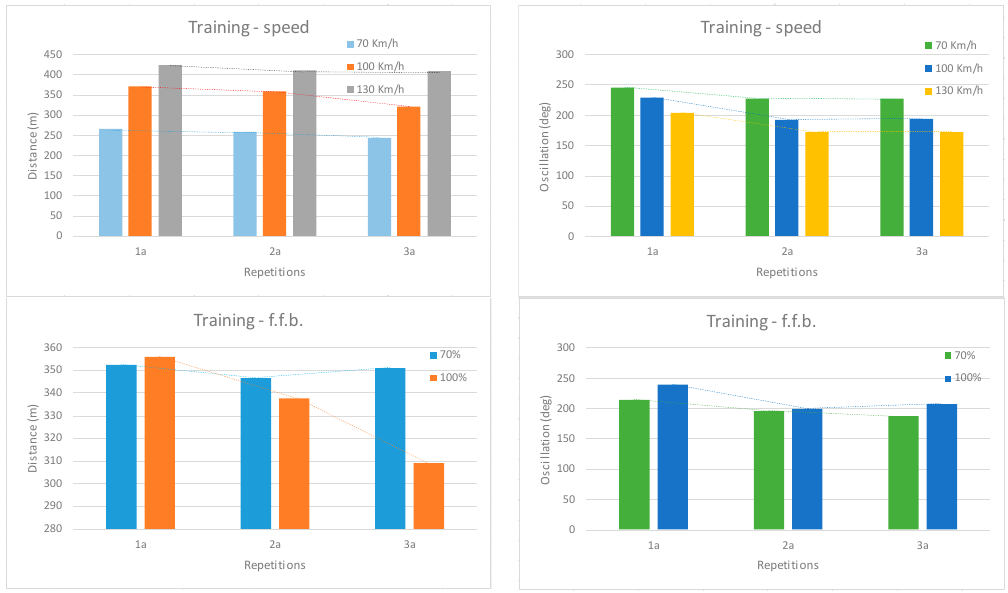
Figure 7. Interactions between number of test repetitions and controlled factors.